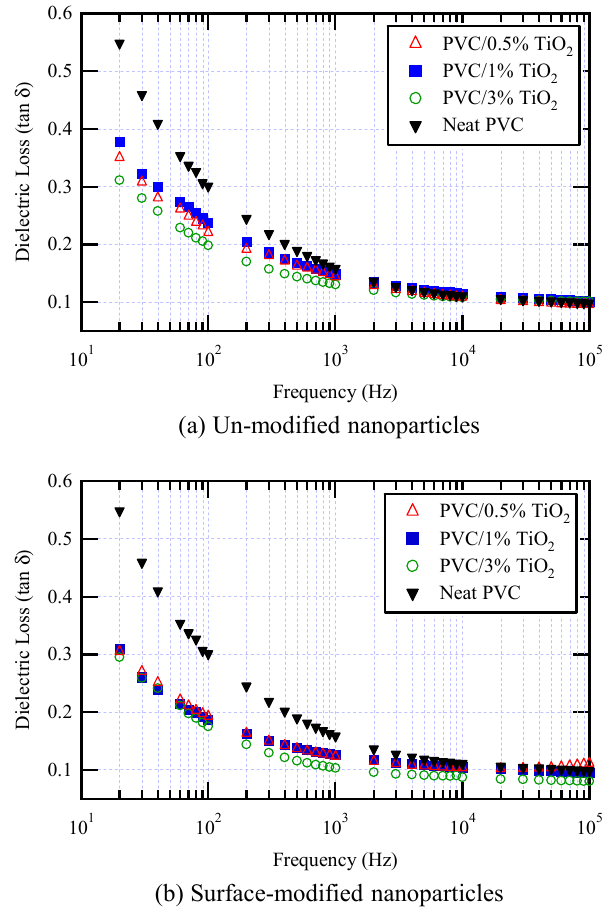
Figure 8. Dielectric loss of PVC/TiO 2 nanocomposites; ( a ) un-modified nanoparticles and ( b ) surface-modified nanoparticles.